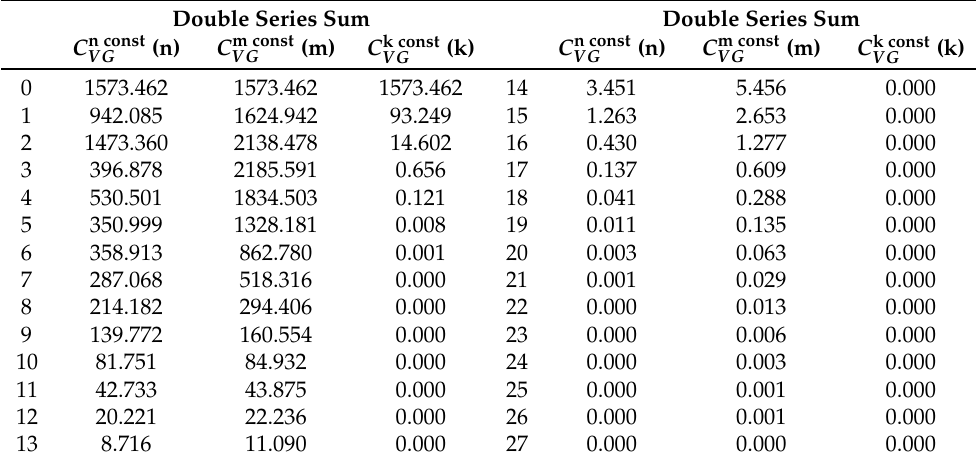
Table 3. Convergence of the three double